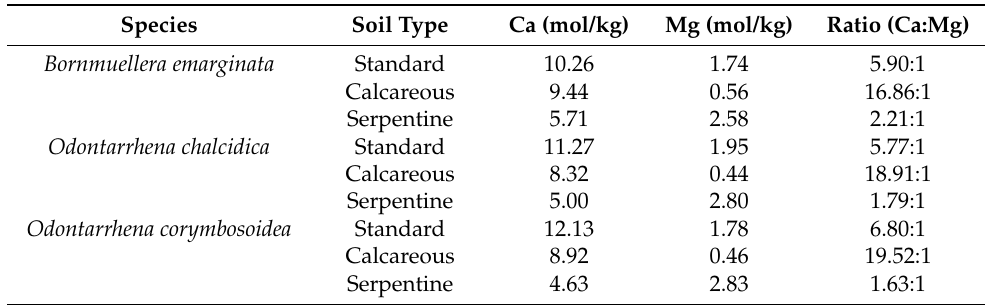
Table 3. Concentration of soluble Ca and Mg in soil used during cultivation (mol/kg). Concentrations also expressed as a ratio of Ca to Mg.